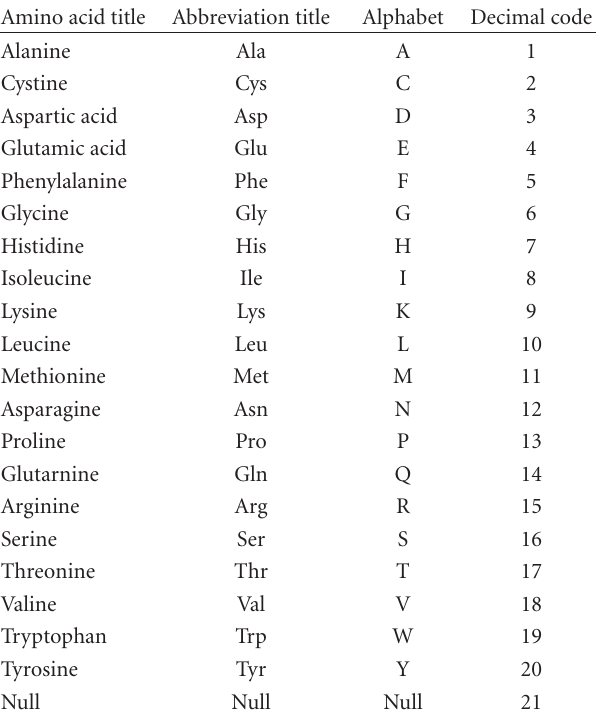
Table 3: Amino acid’s integers encode ranging from 1 to 21 indi- cators of the first subsystem.